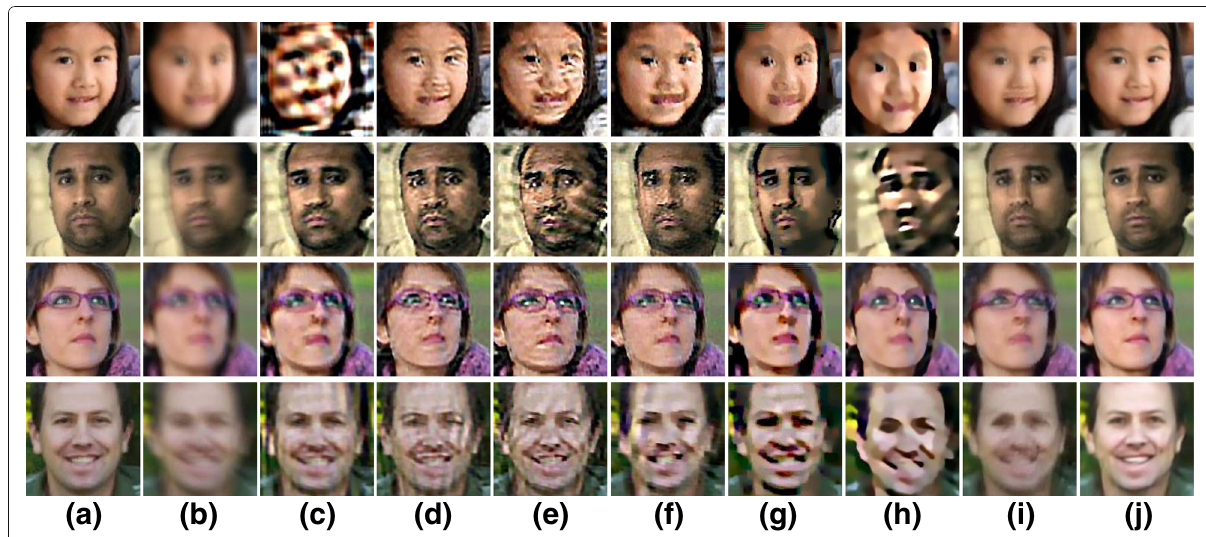
Fig. 8 Comparison with state of the art methods. a Ground truth images. b Blurred images. c Krishnan et al. [17], d Pan et al. [37], e Shan et al. [2], f Xu et al. [18], g Cho and Lee [6], h Zhong et al. [38], i Nah et al. [15], j Ours